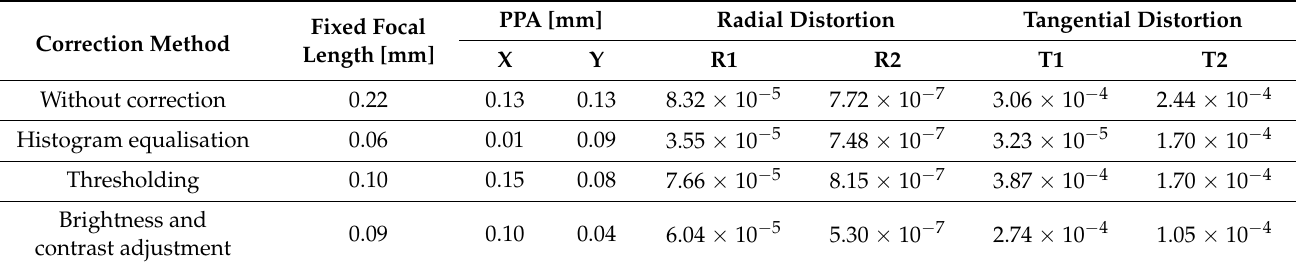
Table 9. Standard deviations for the results of specific methods of thermogram sharpness enhancement.